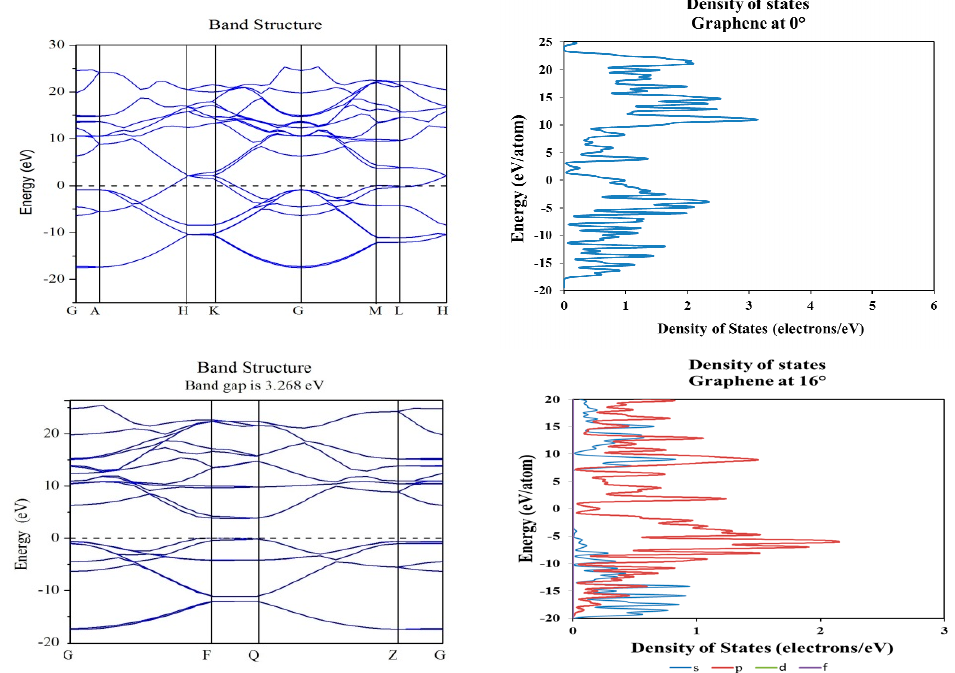
Figure 6. Band structure and density of states plots corresponding to 0° ( top ) and 16° ( bottom ) of rotation in graphene molecular structure; a tuning on the electronic band gap is observed near the Fermi level (0 eV).